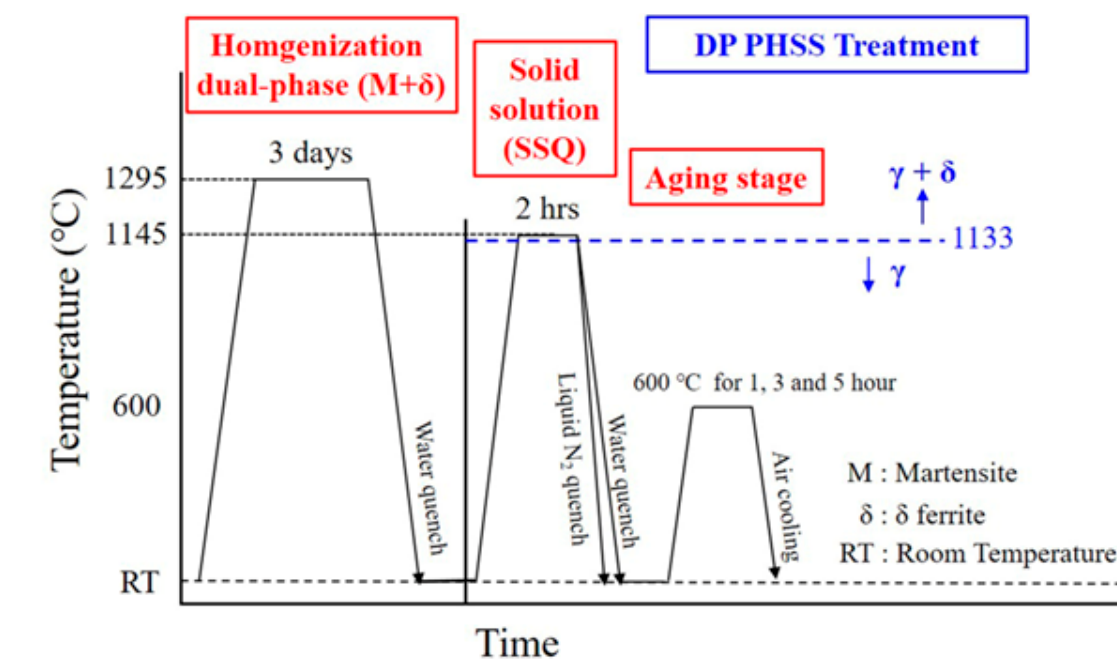
Figure 1. Schematic diagram showing the dual-phase heat treatments and aging at different times. Table 1. Chemical composition of 17-4 PH SS (wt%) by GDS.